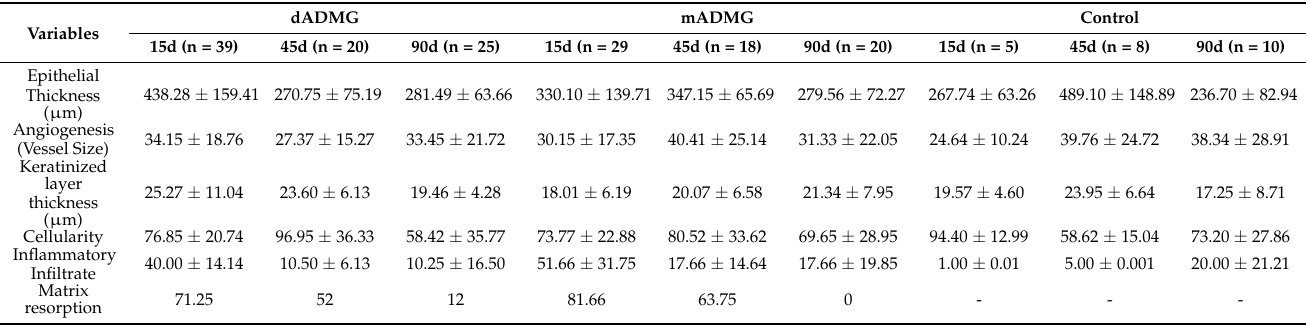
Table 1. Descriptive statistics of the outcome parameters between admg grafts and control groups during follow-up